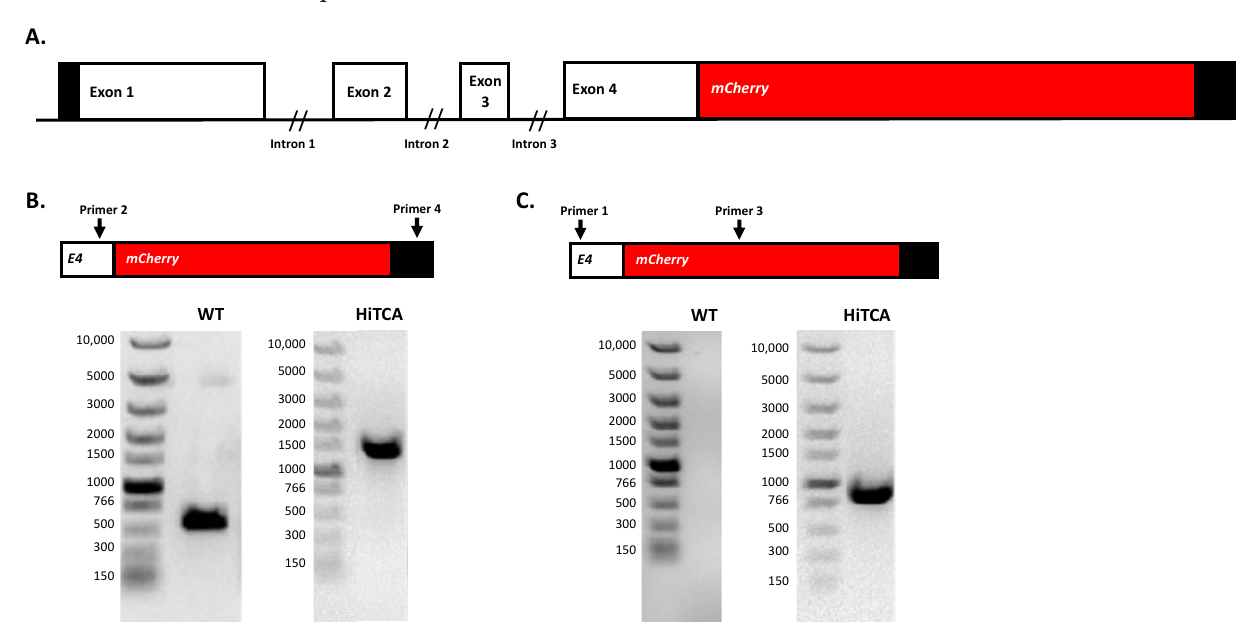
Figure 2. Design and validation of homozygous CAMP mCherry human SC cell line. ( A ) Schematic representation of mCherry insertion at the 3 ′ end of the CAMP gene in the human SC cell line using CRISPR/Cas9. Successful knock-in of mCherry in HiTCA cells but not in wild type (WT) SC cells was confirmed by PCR genotype analysis of ( B ) full-length insert (PCR product of primer 2 (forward) and primer 4 (reverse); expected size of 1348 bp in HiTCA cells and 529 bp in WT) and ( C ) insert junction (PCR product of primer 1 (forward) and primer 3 (reverse); expected size of 851 bp in HiTCA cells and 0 bp in WT).